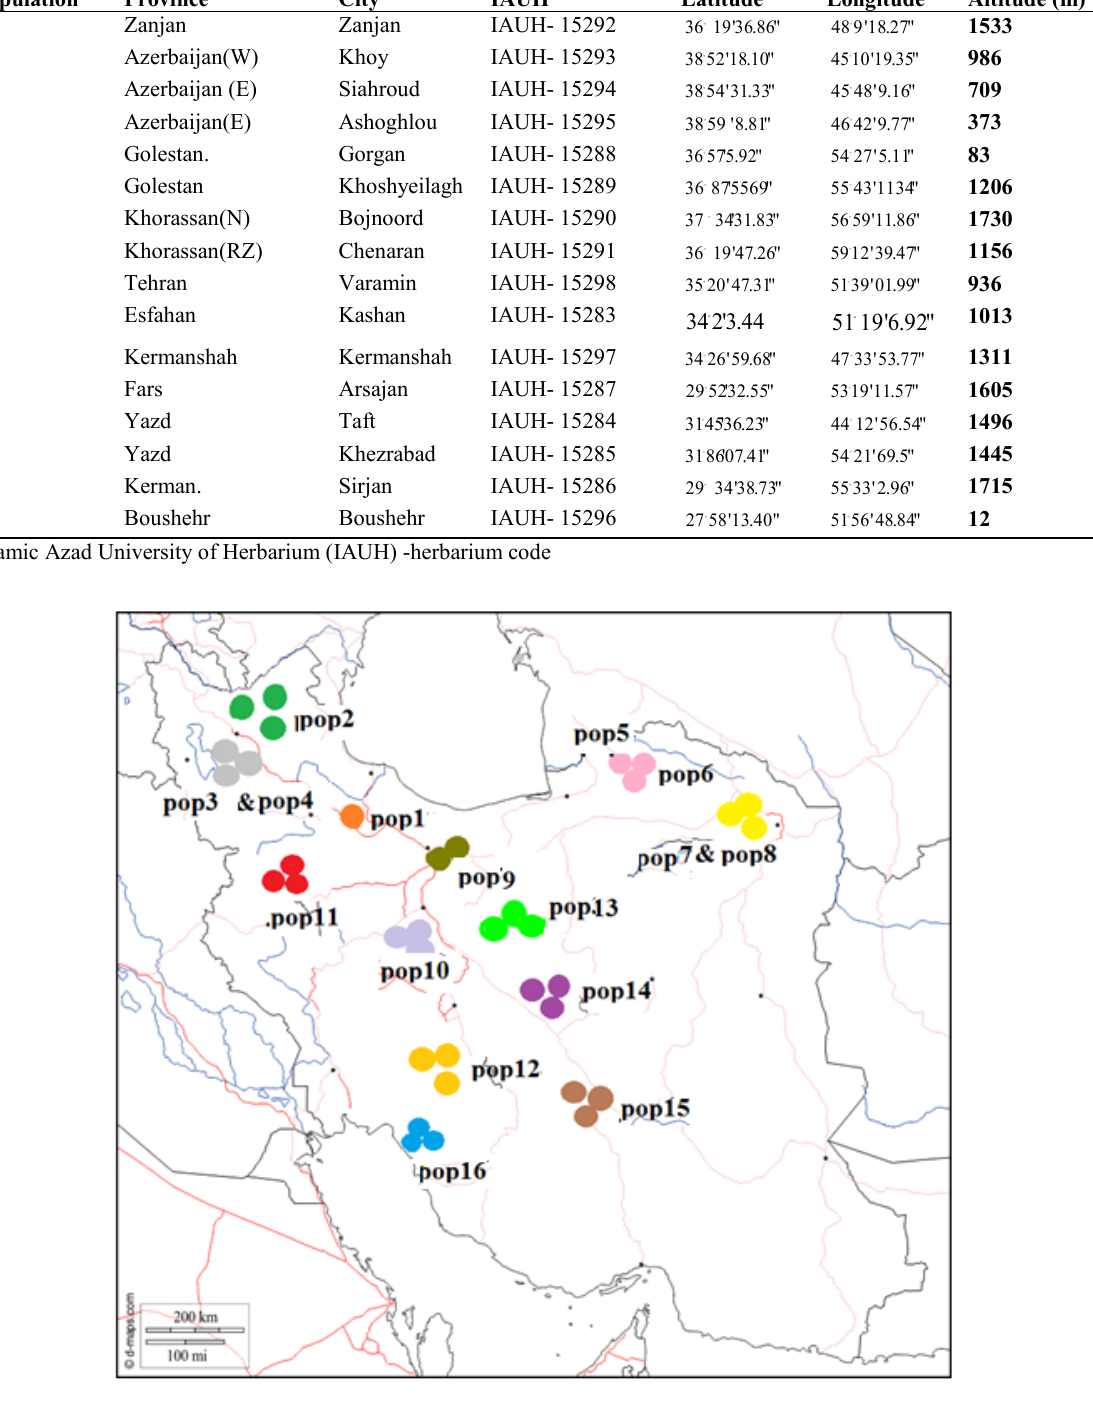
Fig. 1. Distribution map of the studied